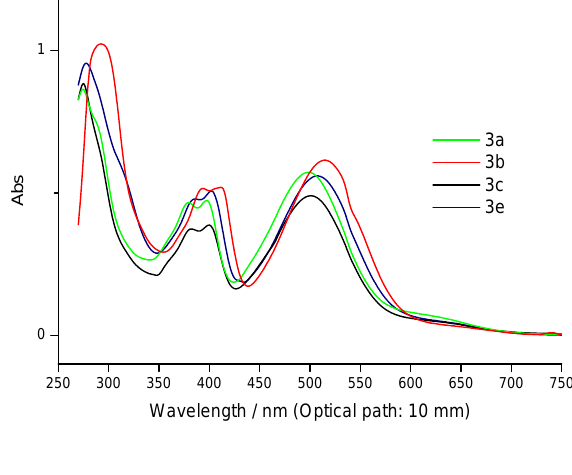
Figure 2. UV-Vis spectra of compound 3 in